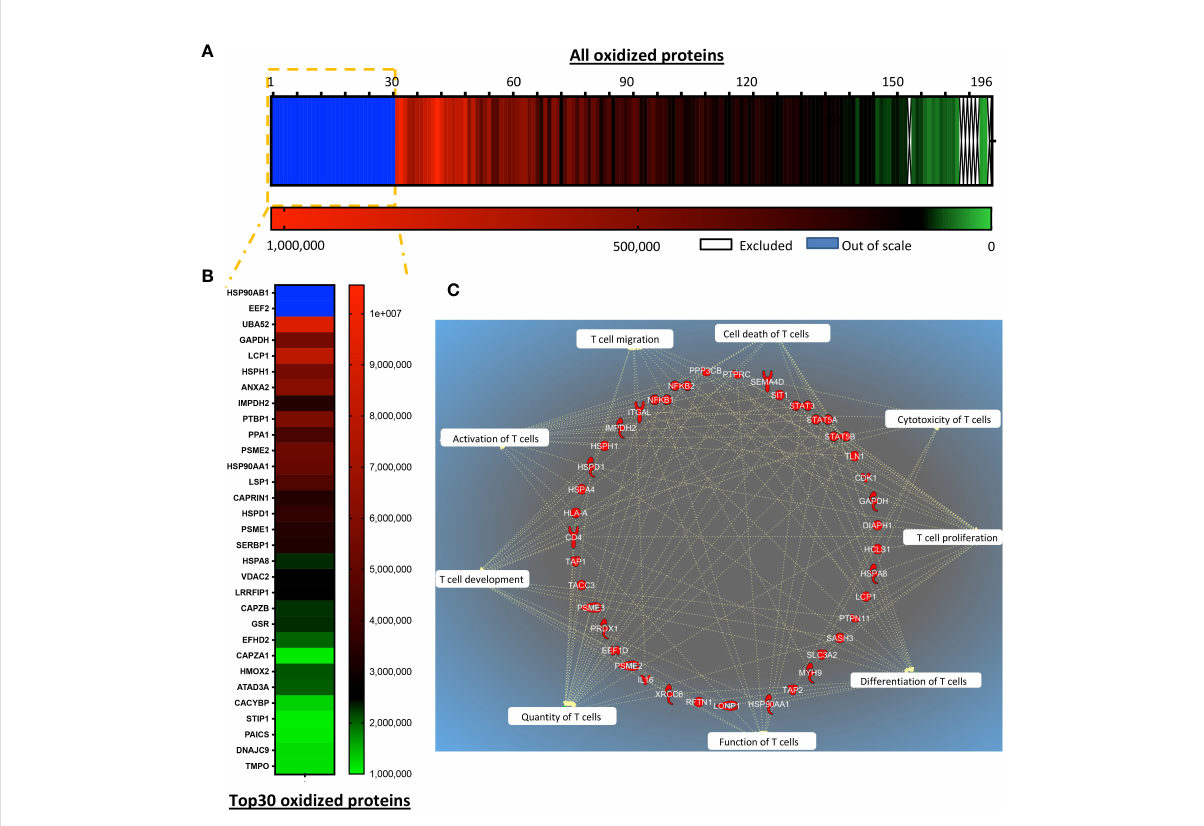
FIGURE 6 TRX1 regulates reduction of key proteins important for T cell antitumor functions. siControl- or siTRX1-transfected T cells were untreated or treated with H 2 O 2 for 5 min. Then intracellular thiol reactions were immediately frozen by NEM alkylation and samples subjected to TRX1 kinetic trapping. TRX1-bound oxidized proteins were separated on SDS-polyacrylamide gels under reducing conditions and analyzed by mass spectrometry. (A) Heat map showing the oxidation state of 196 highly-oxidized proteins. (B) Top 30 highly-oxidized proteins. (C) Pie chart showing the top 10 functions associated with the oxidized